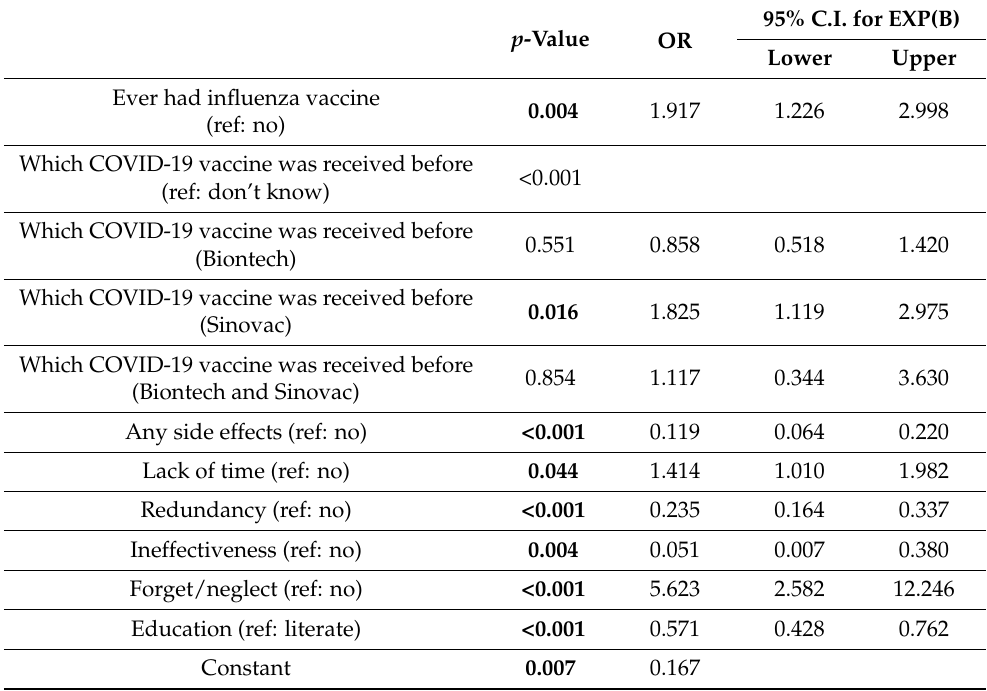
Table 4. Comparison of variables with logistic regression